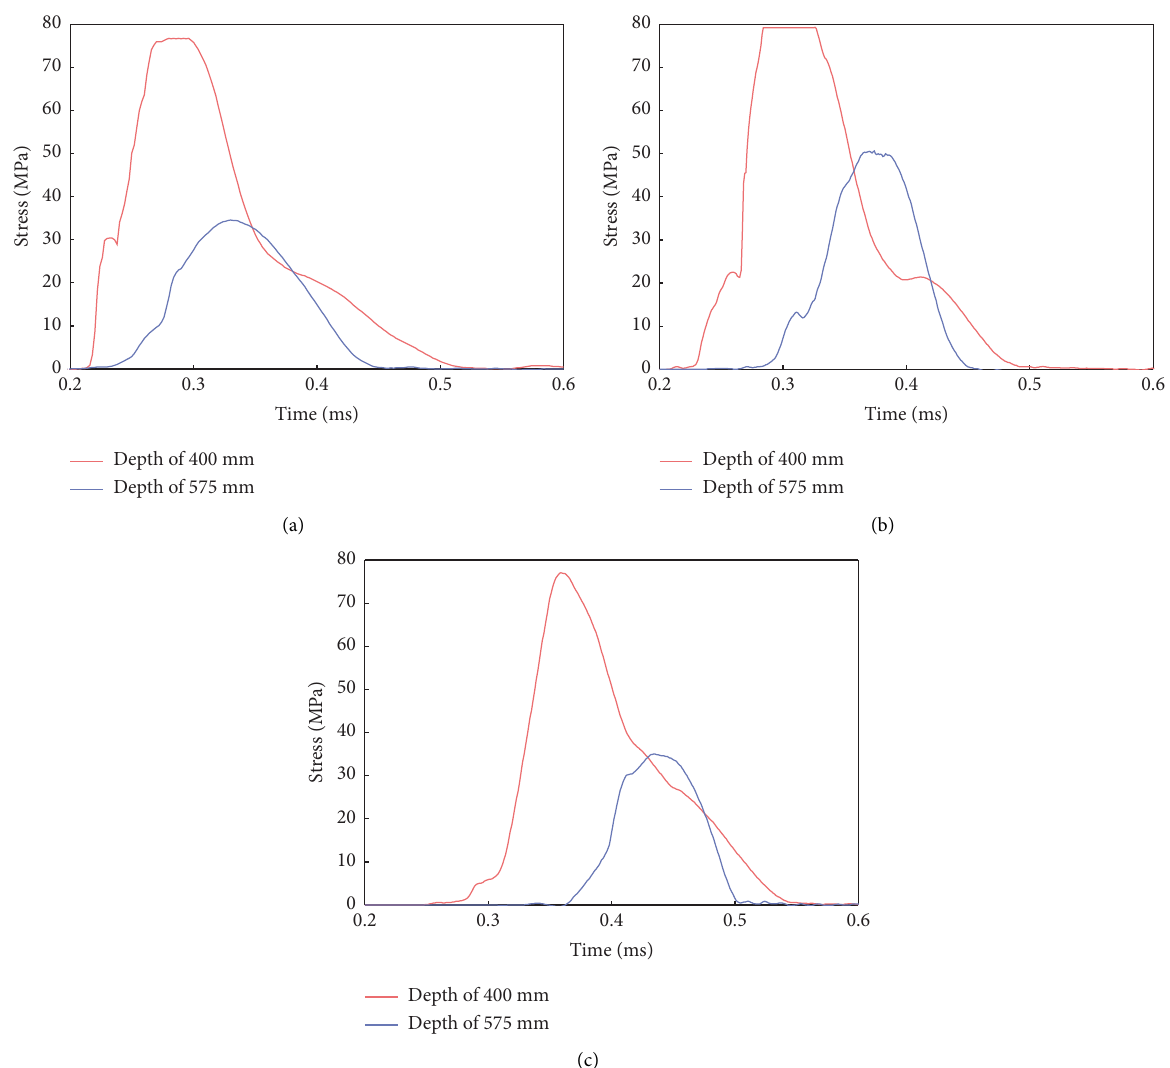
Figure 10: Stress of the concrete pile at diferent depths during EFP penetration. (a) SOD of 30 cm. (b) SOD of 40cm. (c) SOD of